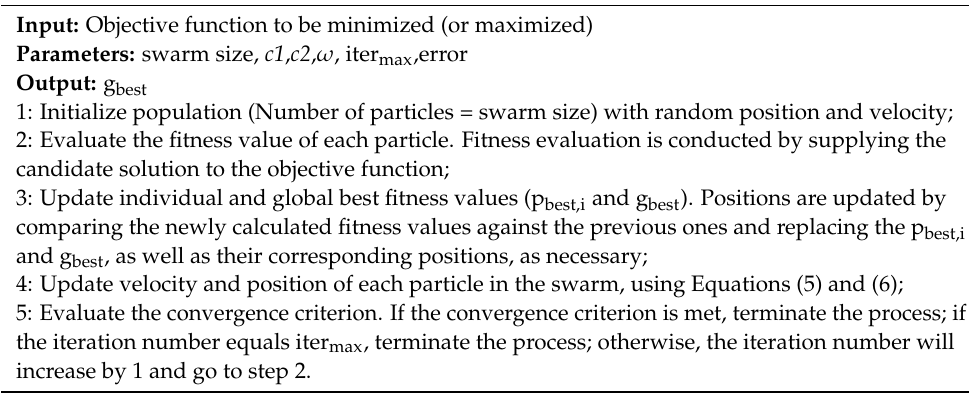
Algorithm 1 Standard particle swarm